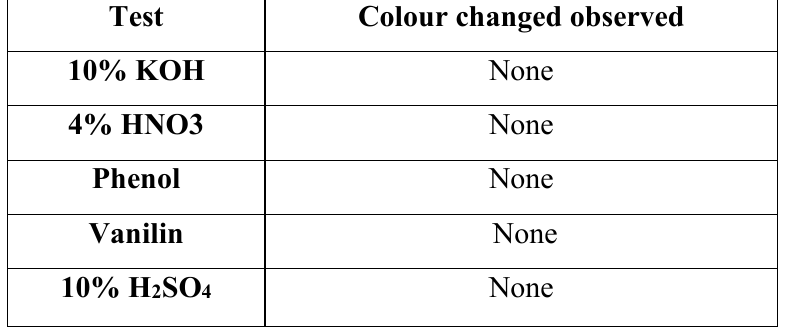
Table 2 Color change profile based on the fruiting bodies of Astraeus asiaticus.